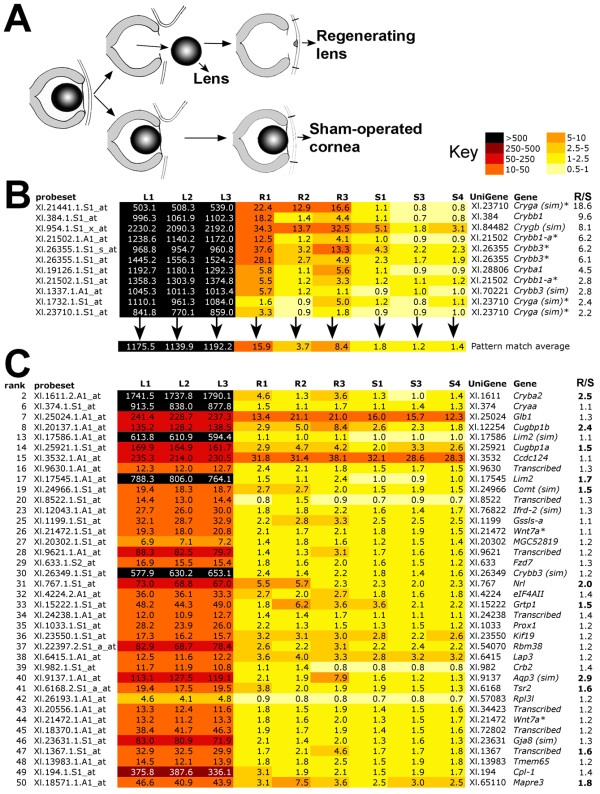
Identification of genes that mimic expression of crystallins during CLT. A) Strategy for identifying CLT specific genes by microarray. Lenses were removed from stage 50 tadpoles and used for RNA extraction of samples L1-3 (differentiated lens). The tadpoles that had undergone lentectomy were allowed to recover for three days before harvesting the cornea for samples R1-3 (regenerating). Finally, a second set of tadpoles were subjected to mock surgery, the cornea was cut, lifted and replaced as for lentectomy but the inner cornea and lens were left in situ. After 3 days corneas were recovered from these animals, generating samples S1, 3 and 4 (sham operated). B) Heatmap of Affymetrix array data showing that the pattern of crystallin expression varies among replicate R samples, with R2 consistently lower. An average expression was used to search for similar patterns in the data. C) Heatmap of top 50 significant matches to the crystallin pattern, excluding the crystallin genes used to generate the pattern average. R/S is the ratio of transcript expression in R1-3 vs. S1, 3 and 4 levels. Bold type in C indicates R > 1.5 × S.